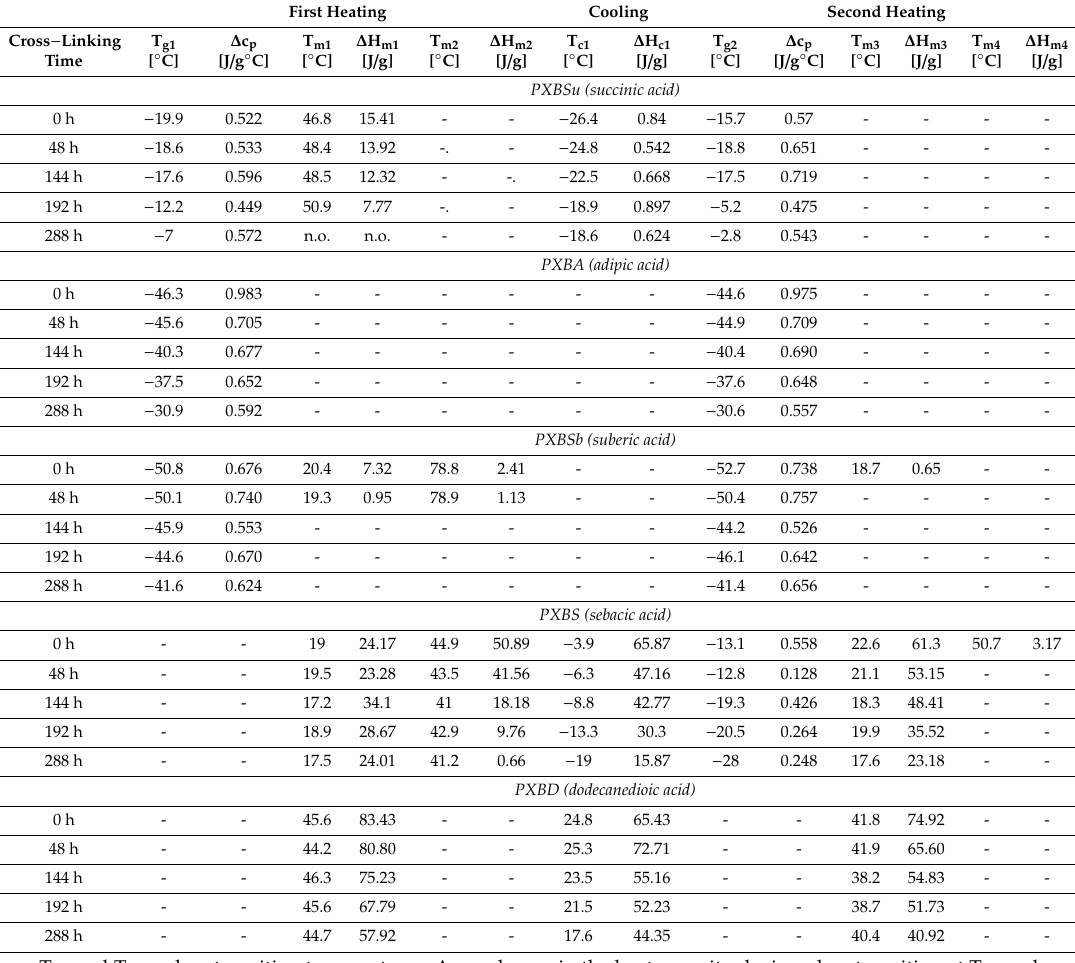
Table 2. Thermal properties of the PXBSu, PXBA, PXBSb, PXBS, PXBD.